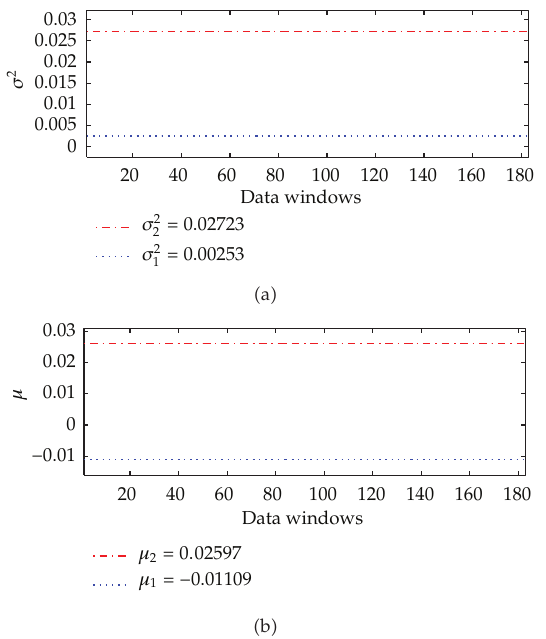
Figure 5: The parameters σ 2 and μ , reconstructed from the S& P 500 data (cid:2) year 2005 (cid:3)